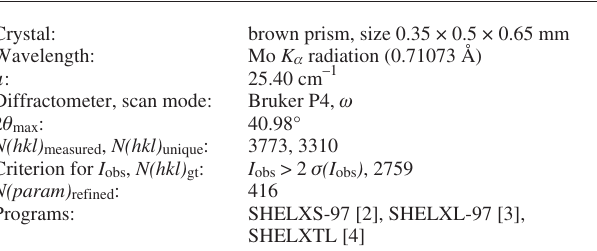
Table 1. Data collection and handling.